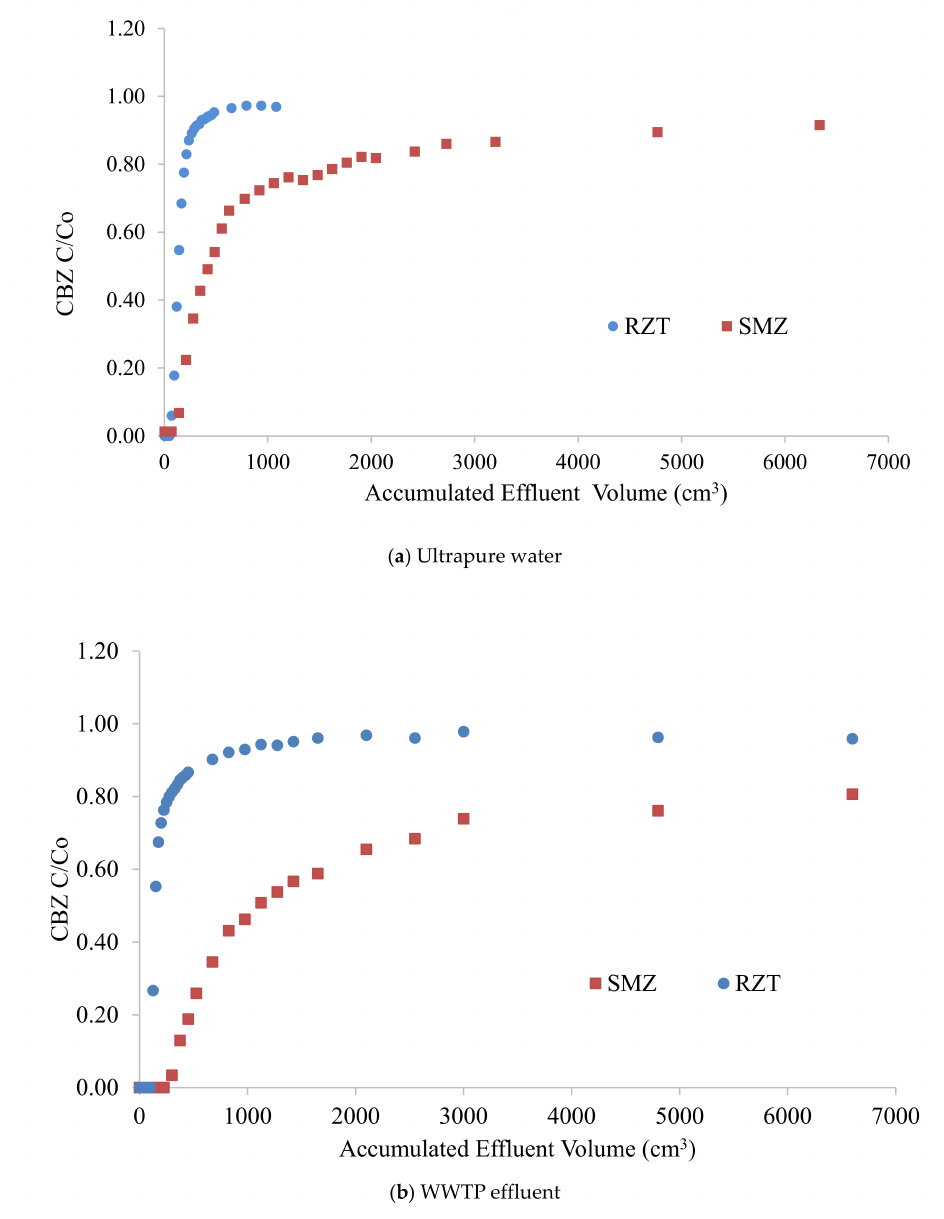
Figure 6. Breakthrough curves (BTC) for sorption of CBZ onto ( a ) Ultrapure water ( b ) WWTP